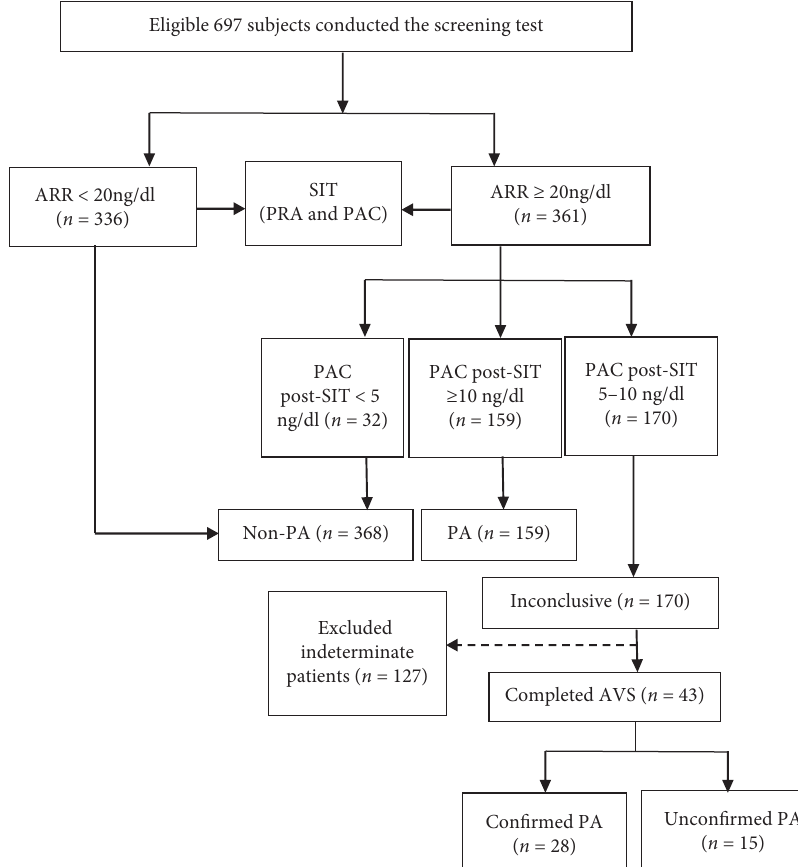
Figure 1: The procedure of subject recruitment. ARR, aldosterone-to-renin ratio; PA, primary aldosteronism; PAC, plasma aldosterone concentration; PRA, plasma renin activity; SIT, saline infusion